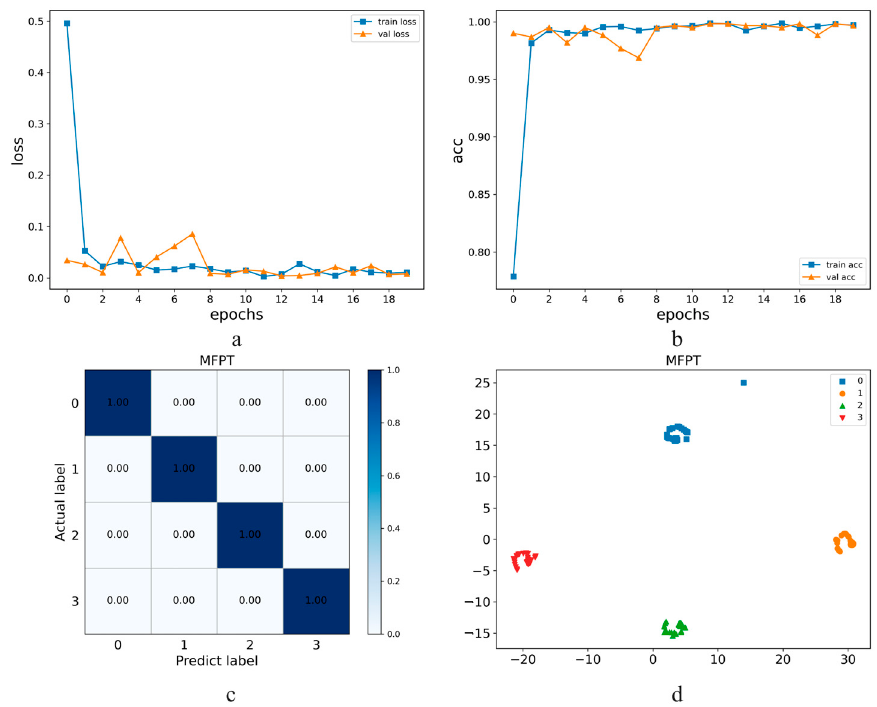
Figure 18. Diagnosis results of MFPT dataset with STFT method: ( a ) Train loss and val loss, ( b ) Train acc and val acc, ( c ) confusion matrix, ( d ) cluster analysis result.